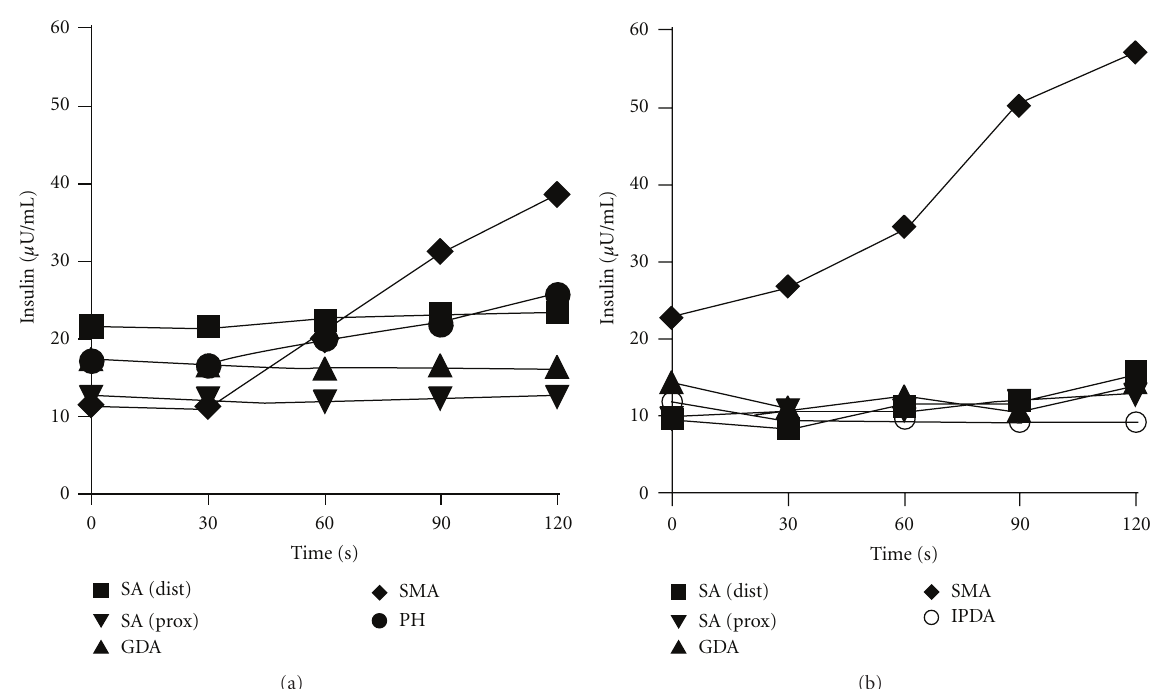
Figure 3: Results of SACI tests at 2004 (a) and 2008 (b). A vascular catheter was located to each specific artery ( (cid:2) splenic (distal), (cid:3) splenic (proximal), (cid:4) gastroduodenal, (cid:5) supramesenteric, • proper hepatic, ◦ inferior pancreaticoduodenal artery). Blood samples were collected from the hepatic vein for measuring insulin concentrations before and after stimulation by calcium gluconate (Ca 2+ 0.025 mEq/Kg).